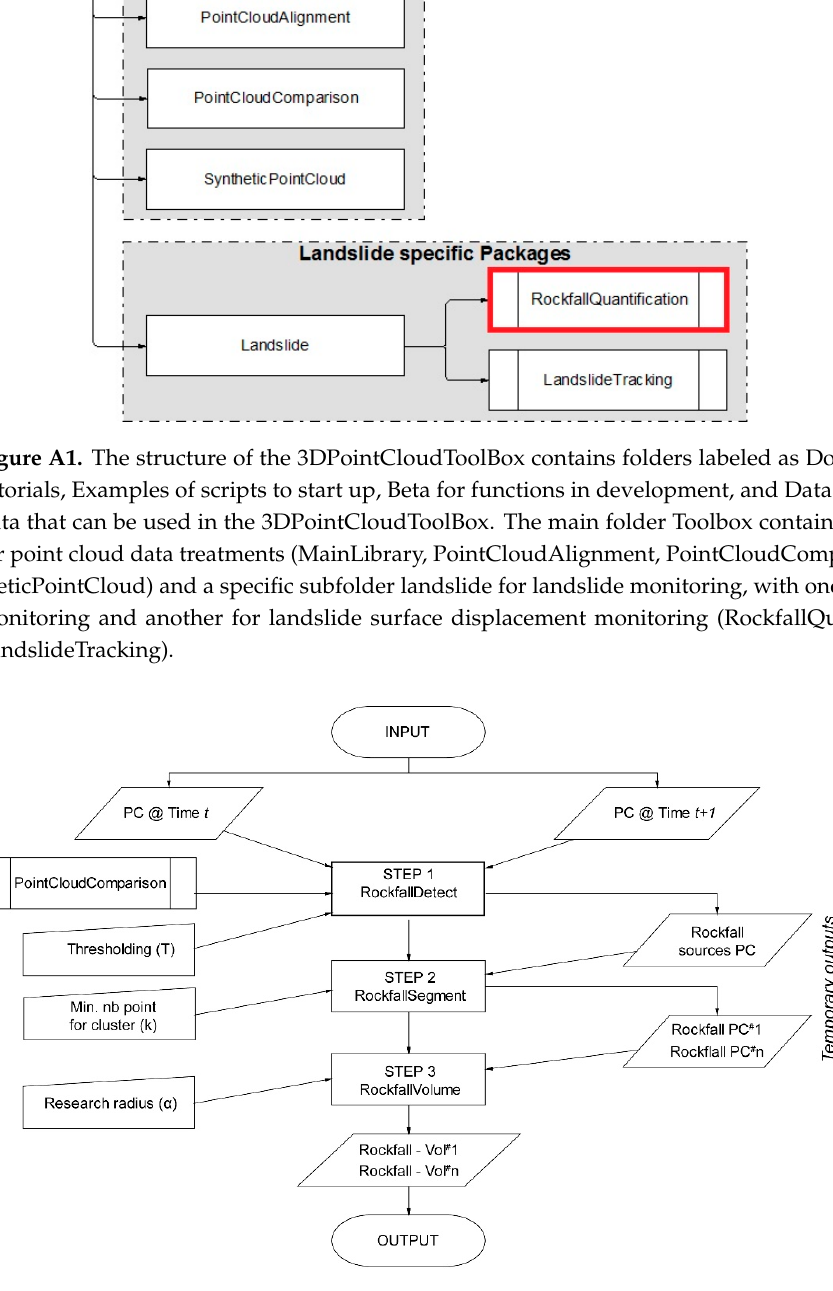
Figure A2. Workflow for the RockfallQuantification package. Table A1. Functions available on the RockfallQuantification package.